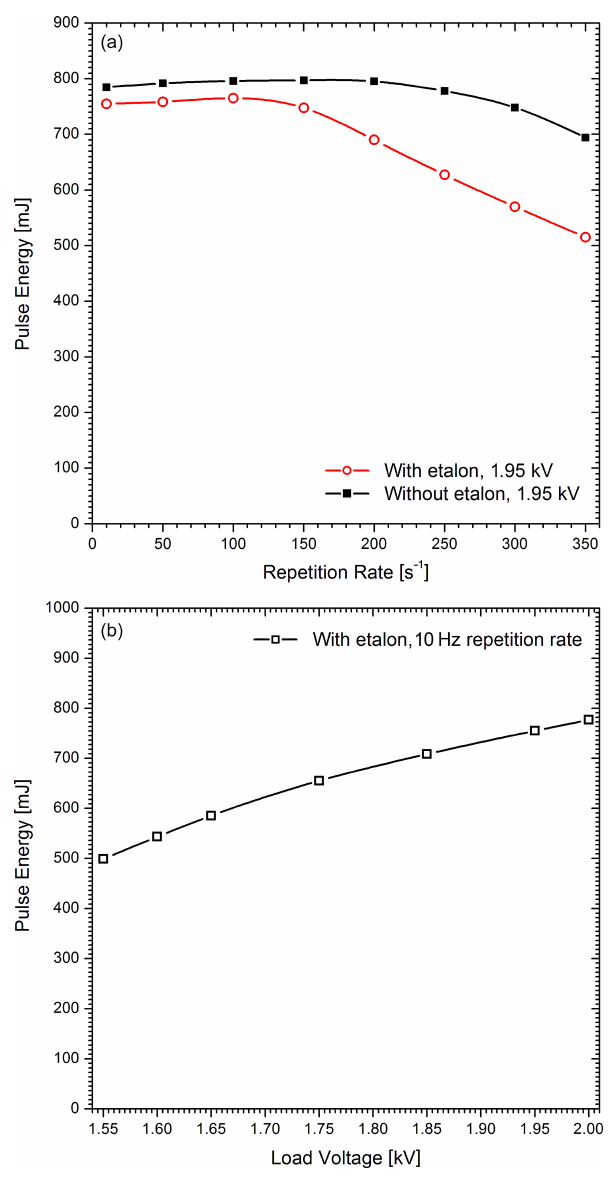
Figure 6. Optimized pulse energy as a function of the repetition rate (a) and the load voltage (b) for comparison. The maximum pulse energy of the broadband laser as delivered is 1.25J (at 2.0kV and